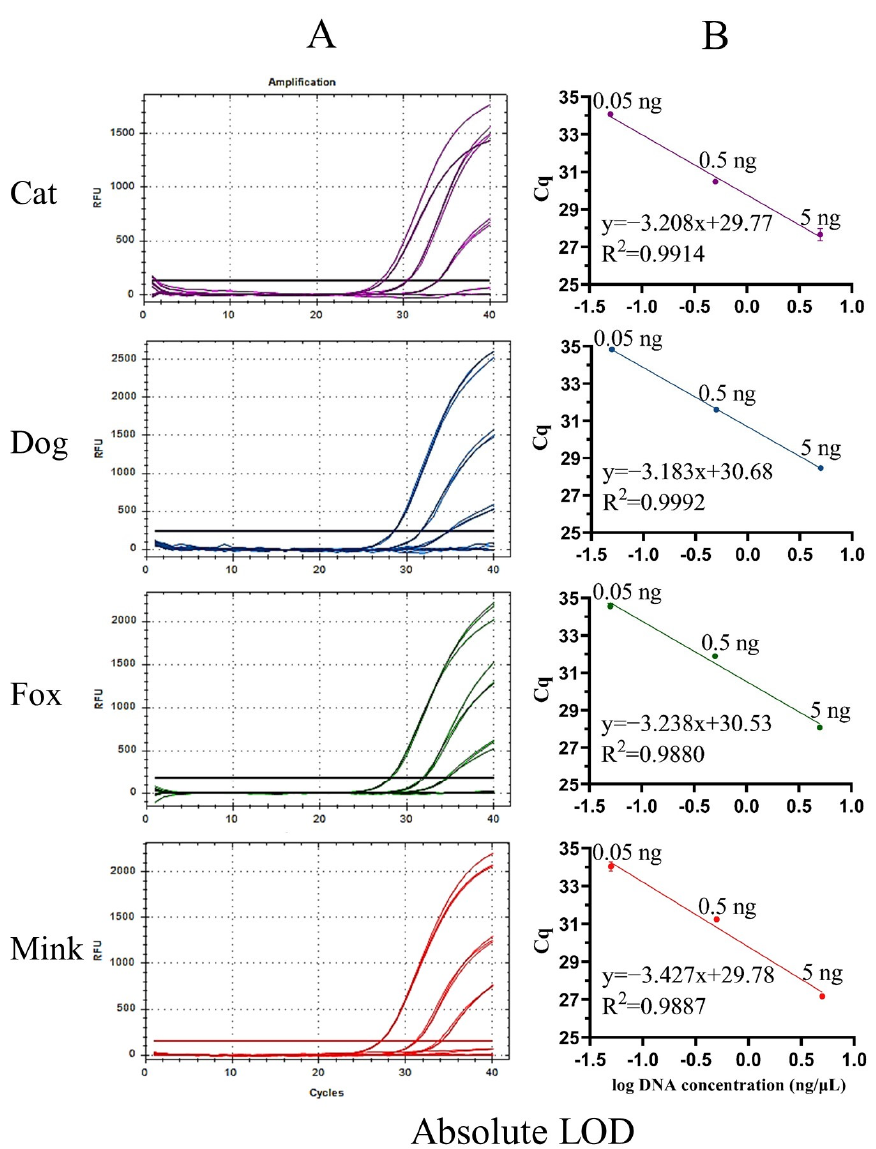
Figure 4. Amplification curves ( A ) and standard curves ( B ) of UP-M-rtPCR using serially diluted (10-fold) DNA (5–0.005 ng).